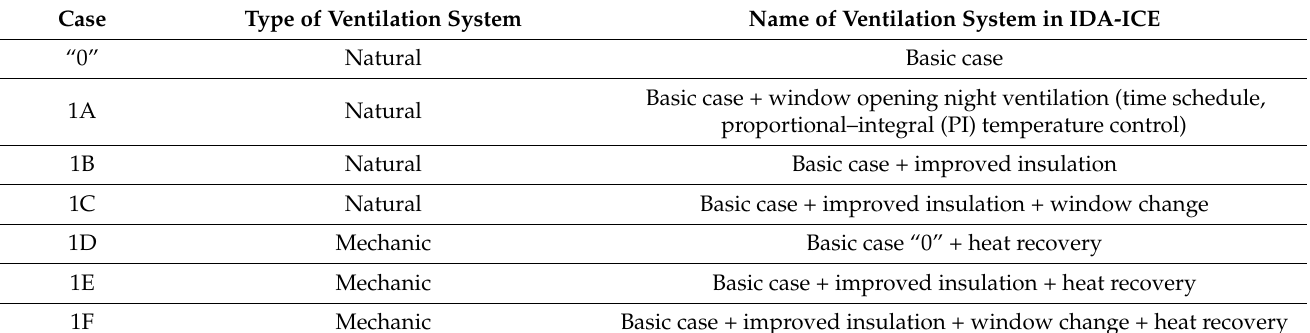
Table 2. Scenarios used during the simulation, their main description, ventilation system identifica- tion and heating used in each of the scenarios